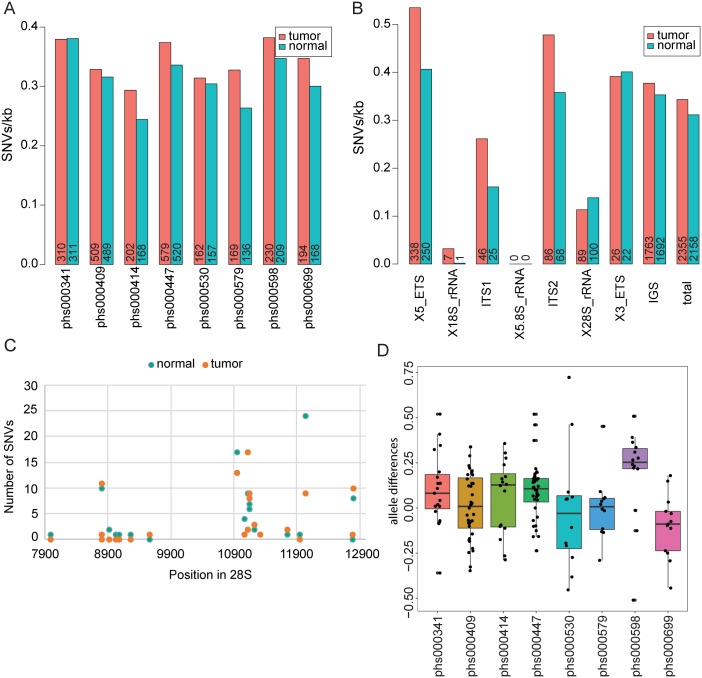
SNV analysis of rDNA loci in the eight cancer genomes from tumor/normal pairs.The match between the test genome and the reference genome sequence was scored at each bp for all genomes. SNVs common to matched pairs were considered “shared” and not included in the analysis in A-C. (A). The plot depicts unique SNVs per kb in the repeat in normal and cancer genomes, with the project number indicated on the x axis, and the allele number on each bar. (B). All unique SNVs for all projects were summed together to depict the SNVs per kb for the different regions of the repeat. The total number of SNVs in each region is annotated on each bar. (C). The number of unique SNVs identified in the 28S region are plotted by position relative to the 45S repeat in GenBank. Hotspots of variation are apparent. (D). The number of alleles for each shared SNVs in each genome pair was used to calculate an average allele number per genome. The average for the normal genome was subtracted from the average calculated for the matched tumor genome to yield the allele difference, plotted by project with results of a t test indicated for each (phs000341, 0.0467, phs000409, 0.7223, phs000414, 0.3458, phs000447, 0.0011, phs000530, 0.8773, phs000579, 0.9782, phs000598, 0.0144, phs000699, 0.0641).